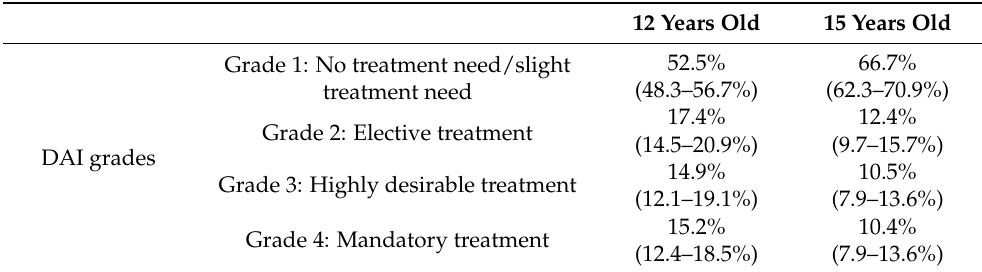
Table 3. Distribution of the orthodontic treatment need grades according DAI, at 12 and 15 years old (CI95%).